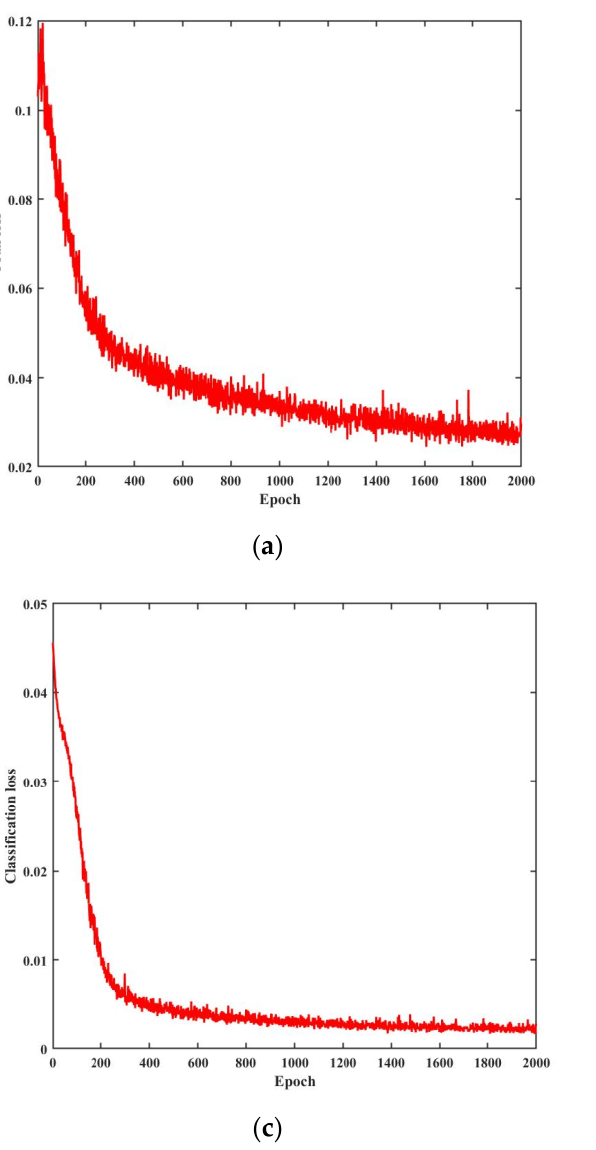
Figure 8. Change in the loss function during training. ( a ) Total loss. ( b ) Bounding box loss. ( c ) Classification loss. ( d ) Confidence loss.